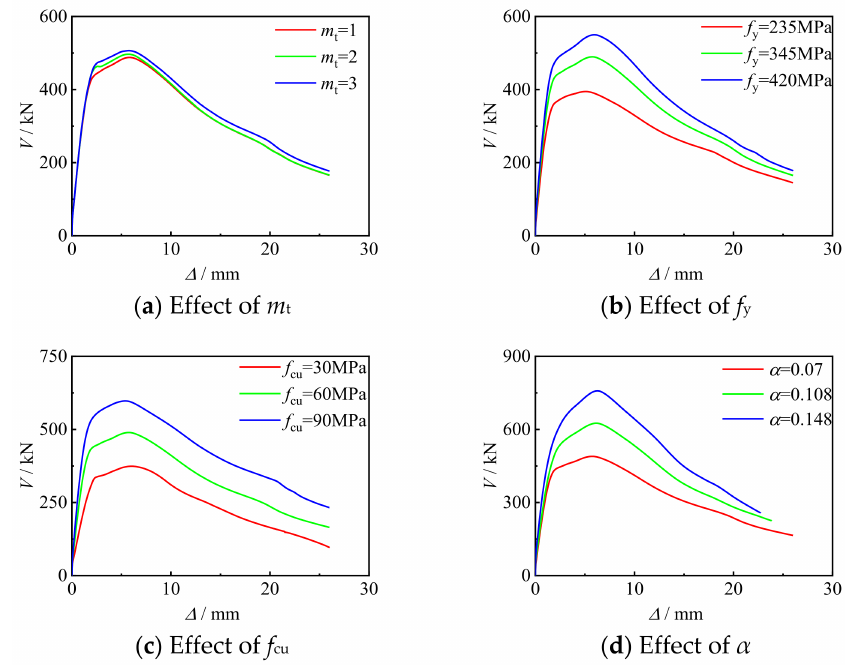
Figure 15. The effects of